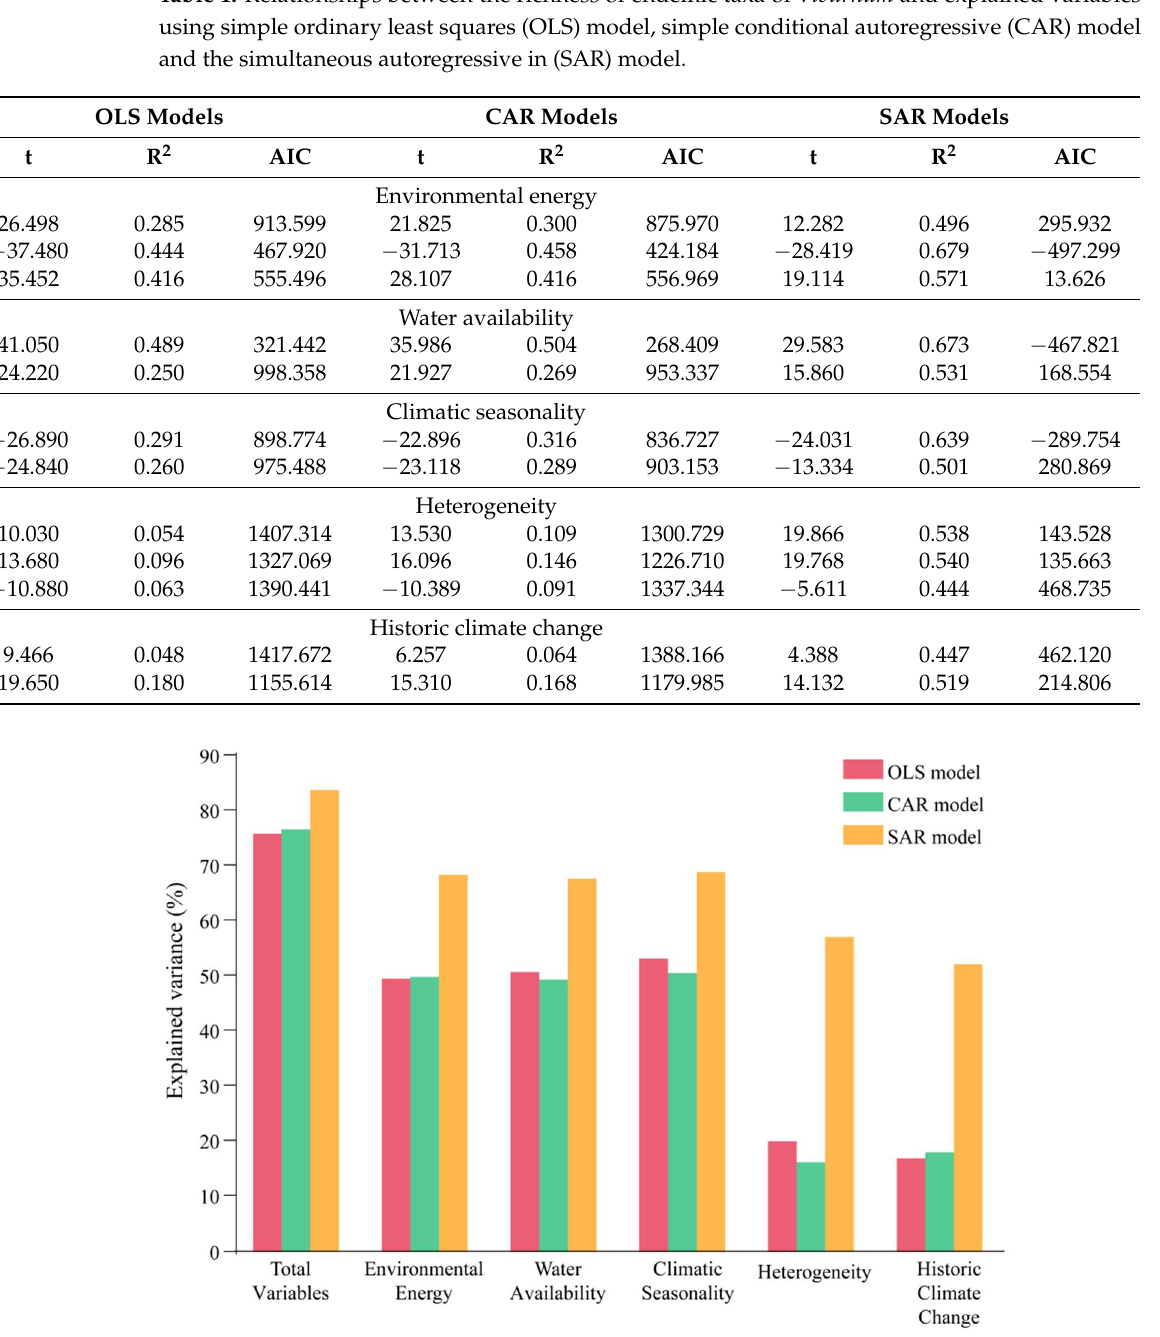
Figure 4. The explanation of endemic richness of genus Viburnum in China by different hypothetical models.